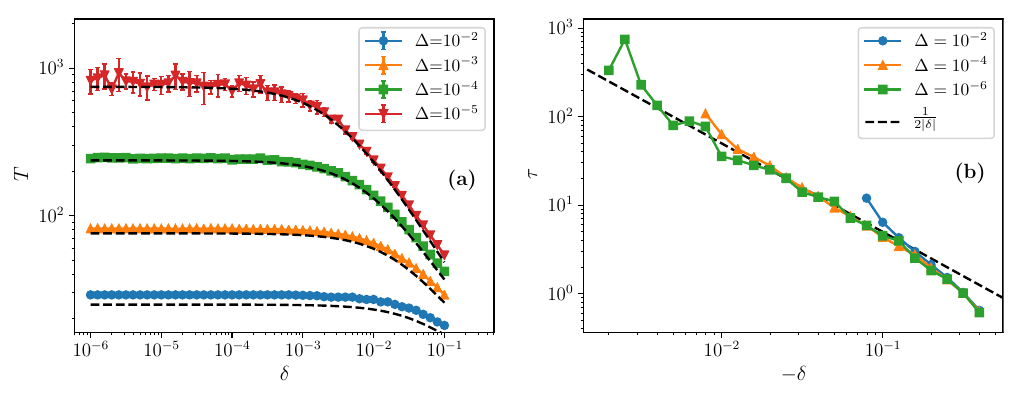
Figure 4. Evolution of S ( t ) following the removal of edges with probability (cid:31) in simulations of uncorrelated 10 8 and m 3 layers of edges, in the case � δ 2 . The degree distribution is P ( 0 ) networks with N = = ≪ 1 / 2 1 ) δ . ( a ) For � >� c ( δ > 0 ) the network P ( q ) e − c c q − 1 /( q P ( 1 ) e − c for q > 0 , with c such that � = − ! ≡ = = + fully collapses. ( b ) For � <� c and small damage (cid:31) the fraction of surviving nodes S ( t ) exponentially relaxes to 1 . These curves were obtained by averaging over 10 realizations of the network and damage in ( a ) some final S f ∼ and over 100 realizations in ( b ). Obtaining smooth curves for the exponential relaxation cases requires a larger number of realizations because, due to the smallness of the variations of S ( t ), fluctuations have a larger relative effect.